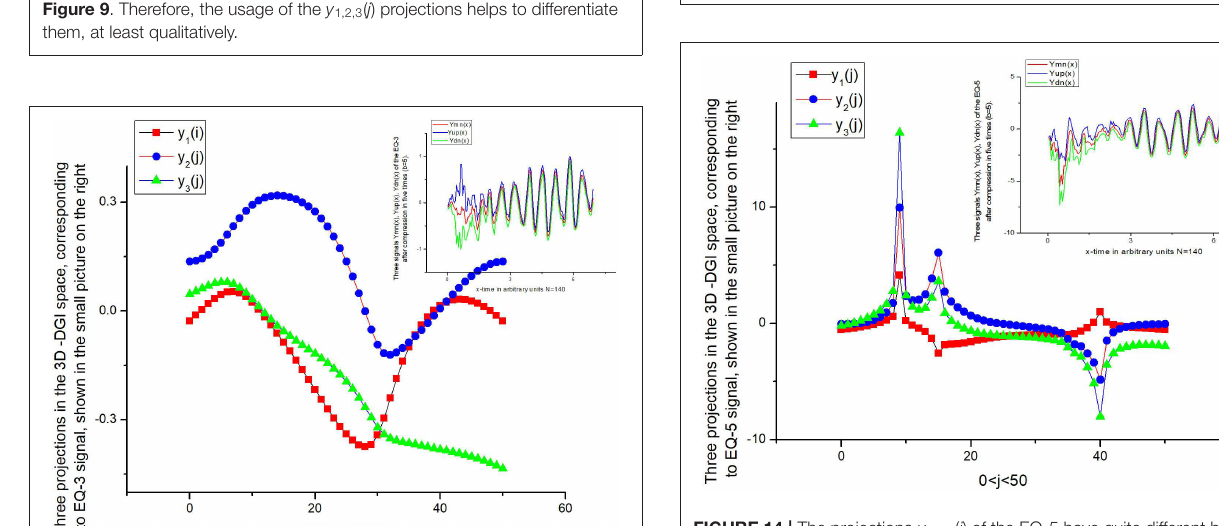
FIGURE 14 | The projections y 1,2,3 ( j ) of the EQ-5 have quite different behavior to those of EQ-1, 3, 4, 6, and the nature of this signal should be analyzed